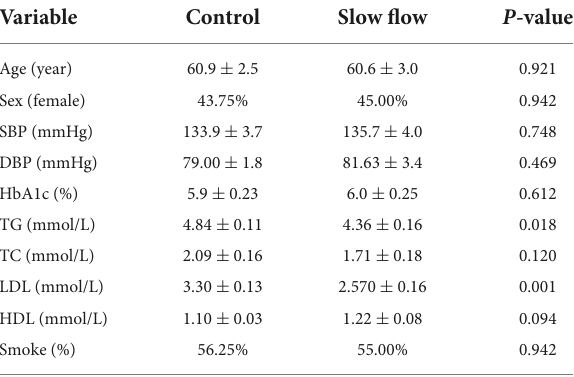
TABLE 1 Demographic and clinical characteristics of study subjects. Variable